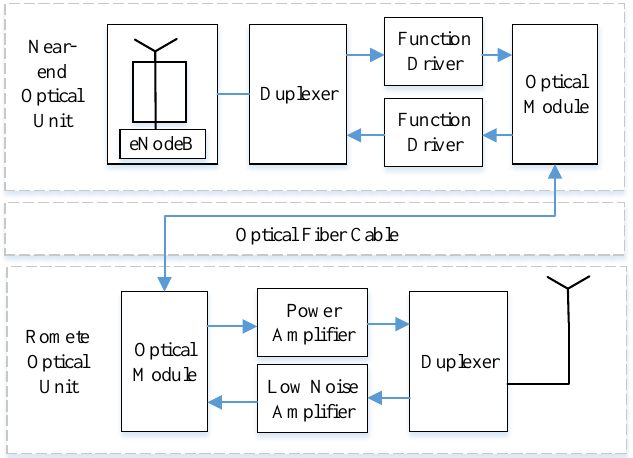
Figure 1. Structural composition of